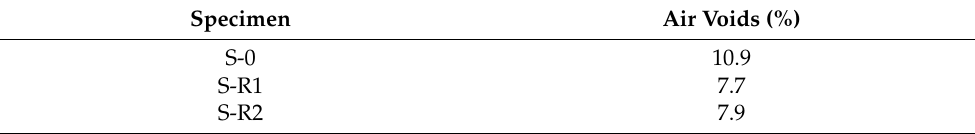
Table 2. The volumetric properties of all fabricated HMA-RAP specimens.